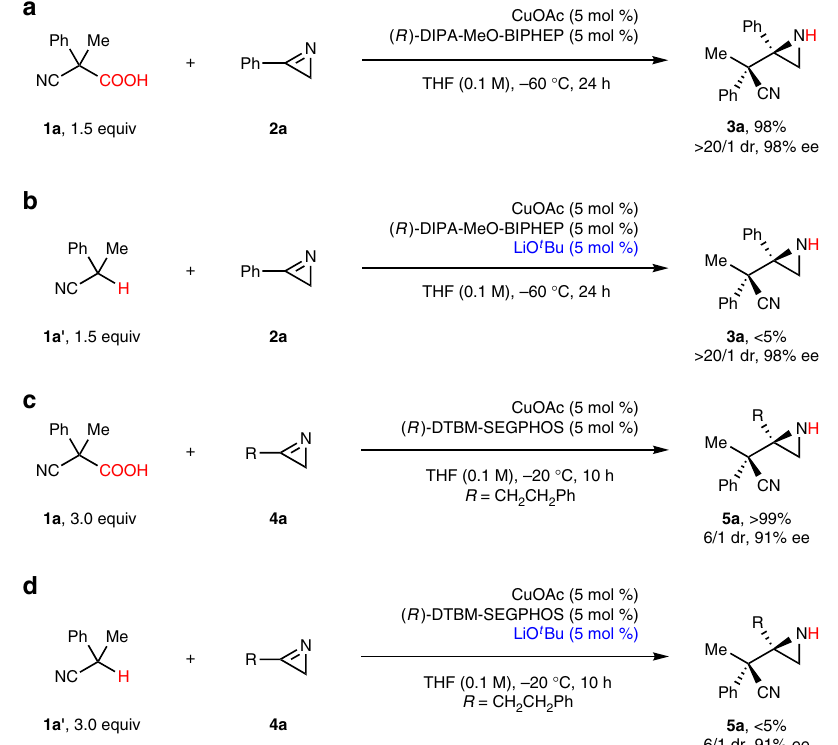
Fig. 3 Demonstration of the strategy ― one substrate activation by the other. a Decarboxylative Mannich reaction of aromatic 2 H -azirine. b Proton- transfer Mannich reaction of aromatic 2 H -azirine. c Decarboxylative Mannich reaction of aliphatic 2 H -azirine. d Proton-transfer Mannich reaction of aliphatic 2 H